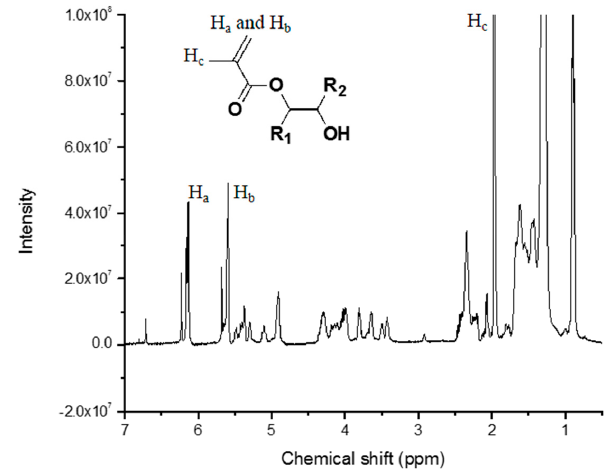
Figure 5. Proton nuclear magnetic resonance spectrum of the methacrylated epoxidized sucrose soyate (MESS) in CDCl 3 .